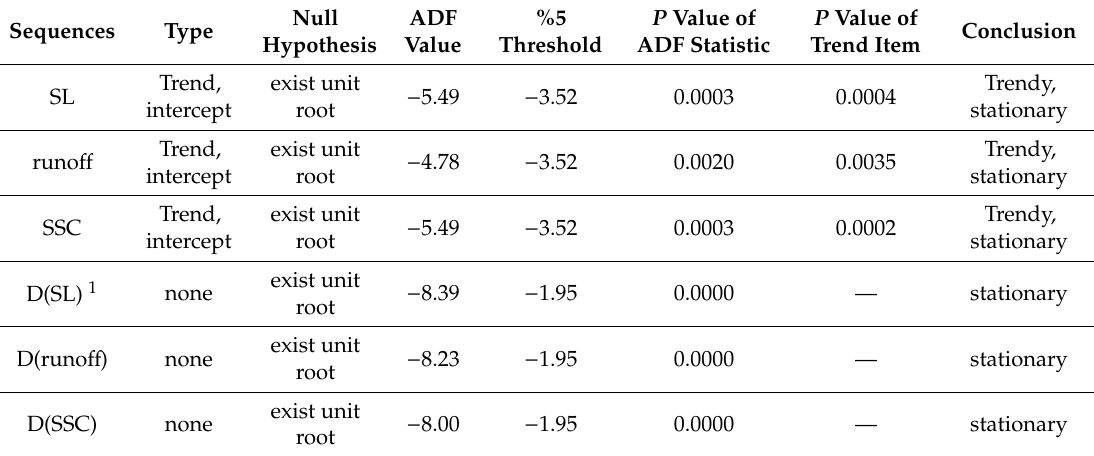
Table 1. Unit root test results of sediment load (SL), runo ff , and suspended sediment concentration (SSC) sequences.